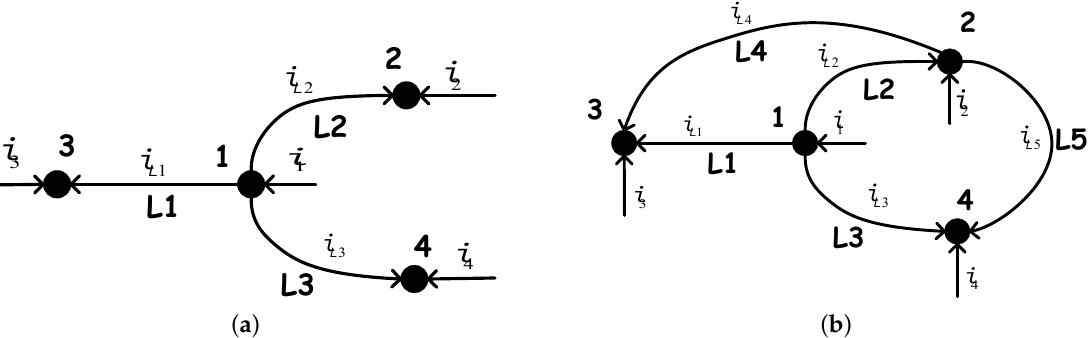
Figure 1. A typical radial network and meshed network: ( a ) radial structure ( n = 4, m = 3); and ( b ) meshed structure ( n = 4, m =